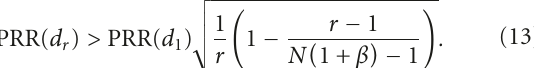
We see that this lower bound is a function of the network size, the portion of energy consumption for transmission ( β ), and the link threshold. The e ff ect of the network size and β is minor since N (cid:6) 1. As N increases, the increase of r that quickly saturates and the gap between small and large N values is quite small. For the link threshold e ff ect, r decreases as the link threshold